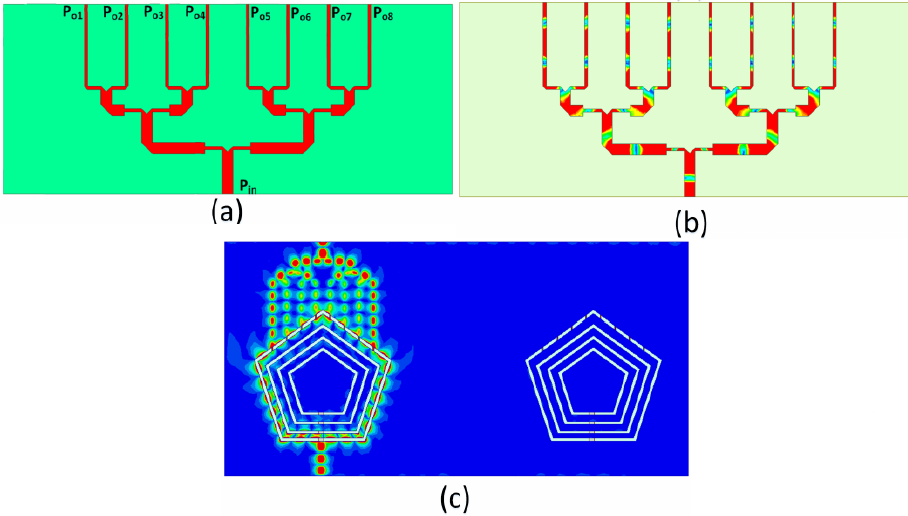
Figure 5. Current density distribution at 28 GHz: ( a ) PD, ( b ) CD of PD, ( c ) Ant-3 at 28 GHz.